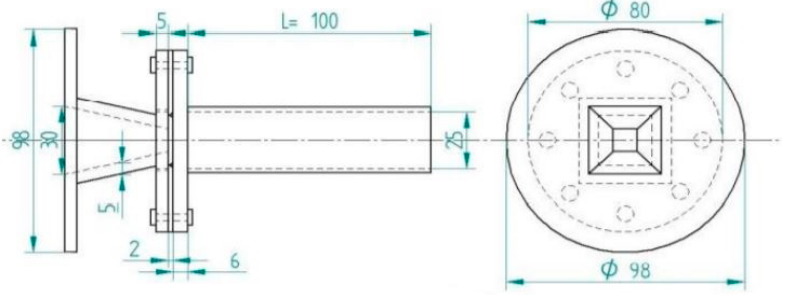
Figure 10. Dimensions of nozzle and duct [19].